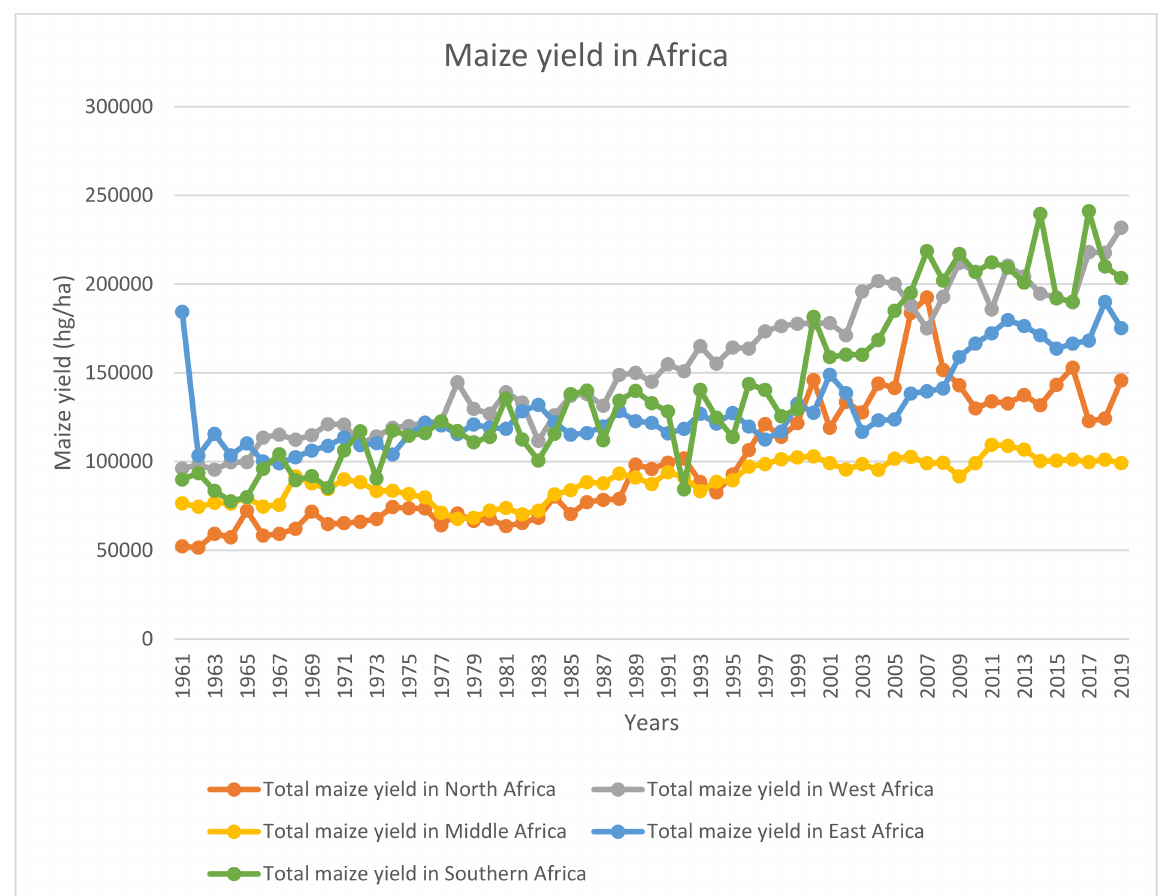
Figure 6. Maize yield evolution across different African regions between 1961 to 2019.